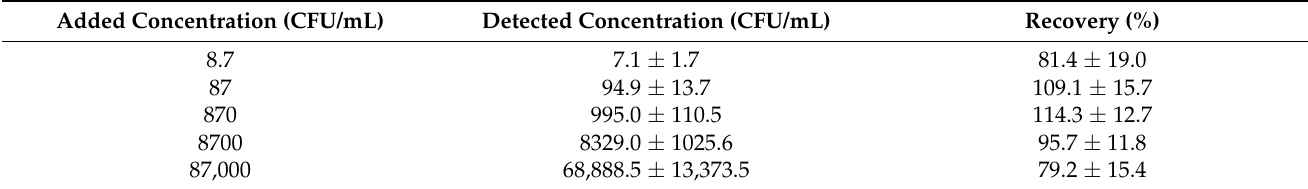
Table 1. Detection of Salmonella Typhimurium in spiked milk samples (N =